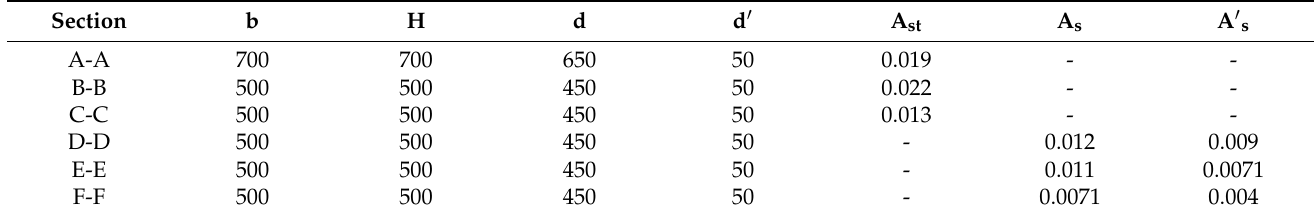
Table 1. Properties of the beam and column sections (mm) [7,28].